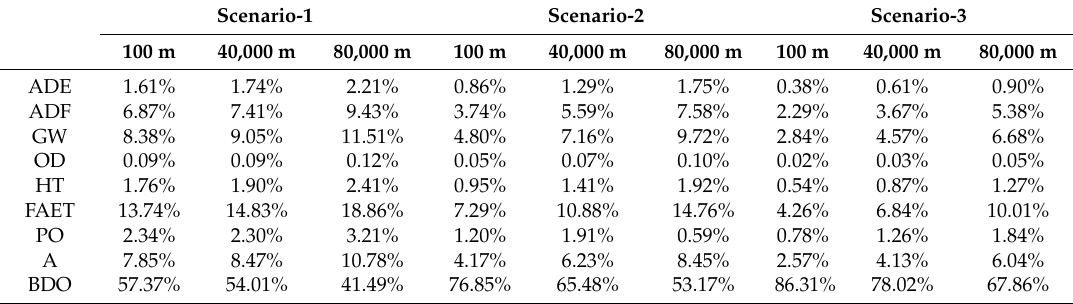
Table 2. Contribution of different impact categories to total impact of each scenario at 3 different downstream: 100 m, 40,000, and 80,000